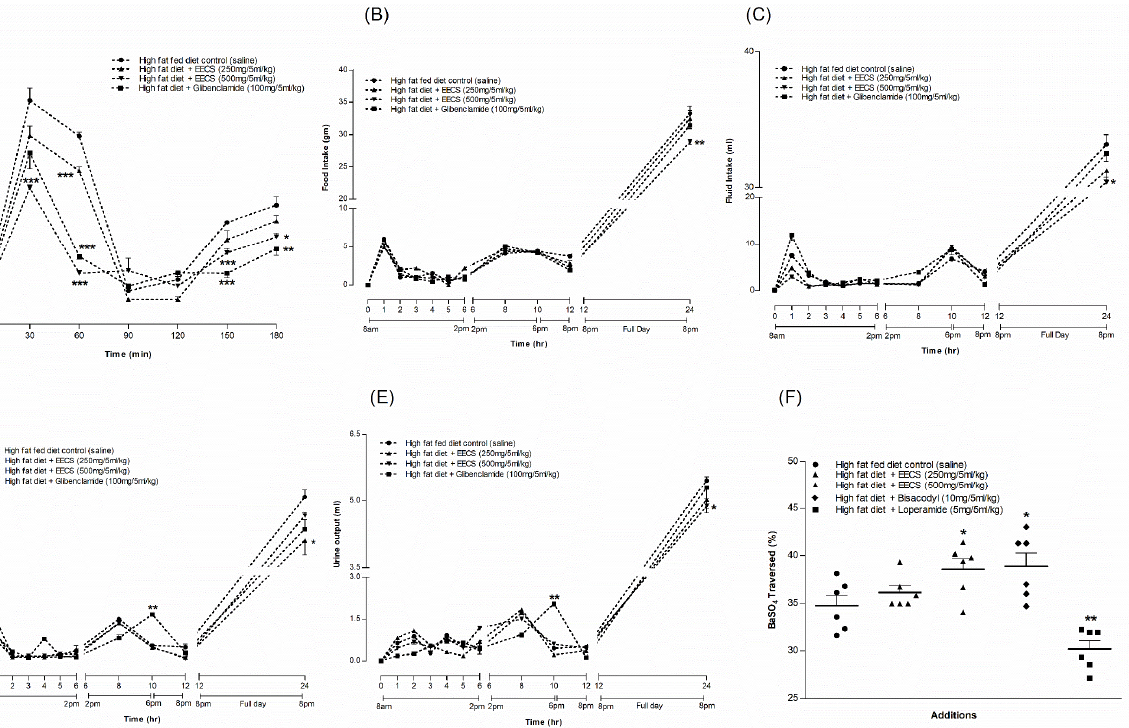
Figure 4. Effects of EECS on ( A ) food intake during feeding test and ( B ) food intake, ( C ) fluid intake, ( D ) stool and ( E ) urine output after 24 h of metabolic study. ( F ) BaSO 4 traversed. Values n = 6 for feeding test and metabolic parameters are mean ± SEM. *, **, *** p < 0.05–0.001 compared to high-fat-diet-fed control